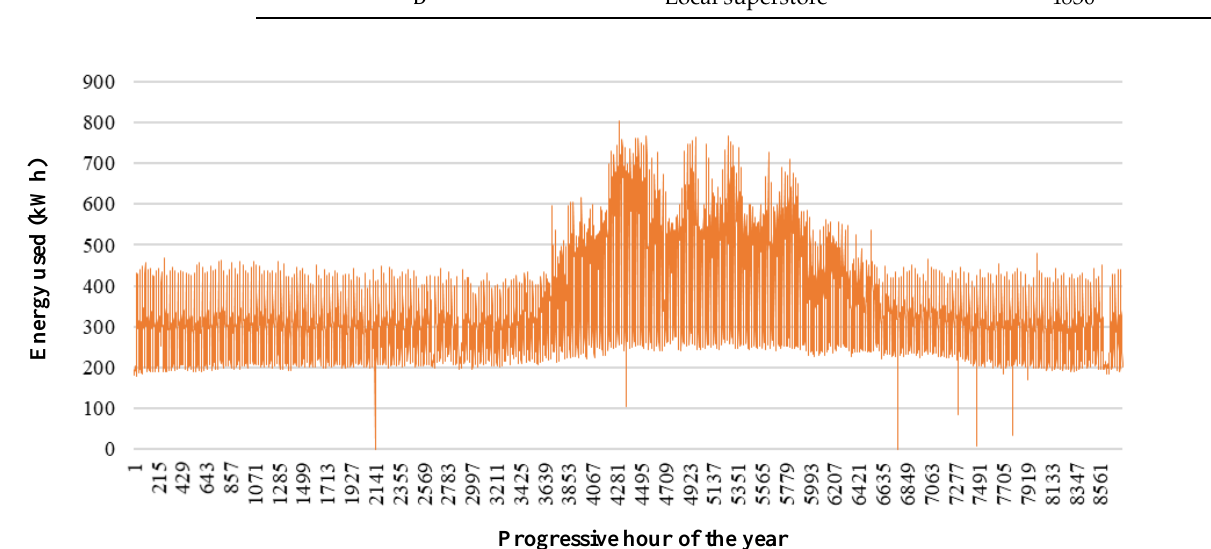
Figure 2. Hourly trend of energy consumption for the higher size supermarket (for Store A).